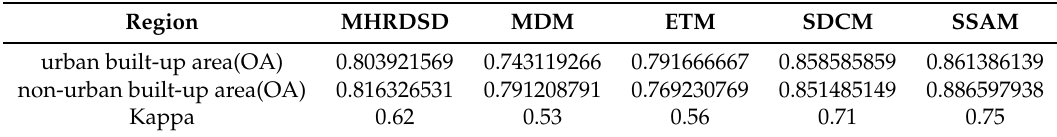
Table 2. Methods comparative accuracy analysis.